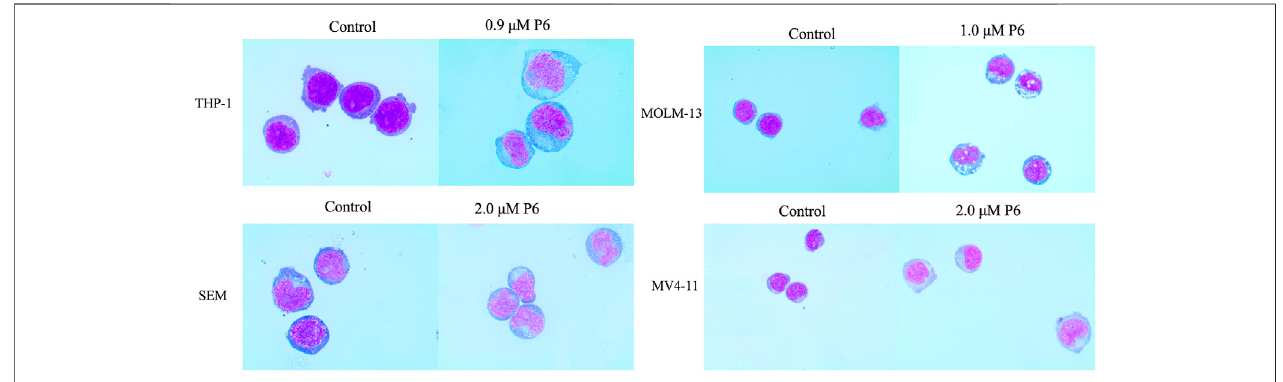
FIGURE 7 | Wright-Giemsa staining images of cells captured by oil immersion lens (×1,000).